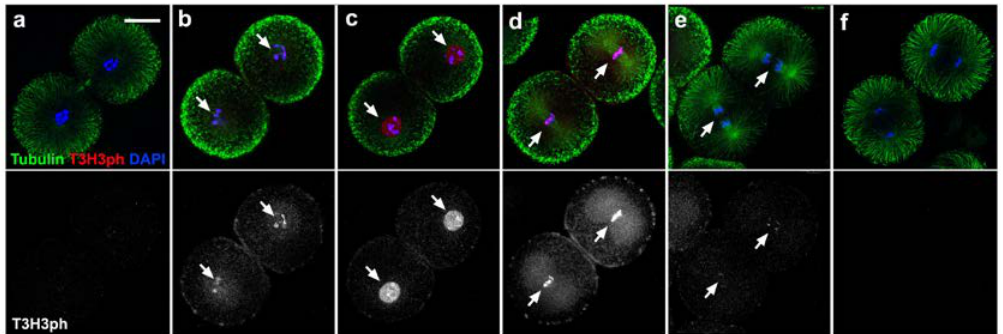
Figure 3. A peak of T3H3 phosphorylation accompanies the second mitotic division in S. granularis embryos. ( a – f ) Pictures correspond to confocal equatorial optical sections obtained by imaging embryos immunostained for Tubulin (shown in green, top panels), T3H3ph (red in the top panels, greyscale in bottom panels) and DAPI (blue in top panels). Images present consecutive stages illustrating progression through the second embryonic division. Scale bar, 30 µm. ( a , b ) The T3H3ph signal (white arrows) appeared during chromatin condensation. ( c , d ) A strong T3H3ph signal (white arrows) was observed during the prometaphase ( c ) and metaphase ( d ). ( e , f ) The T3H3ph signal (white arrows) disappears during the anaphase.